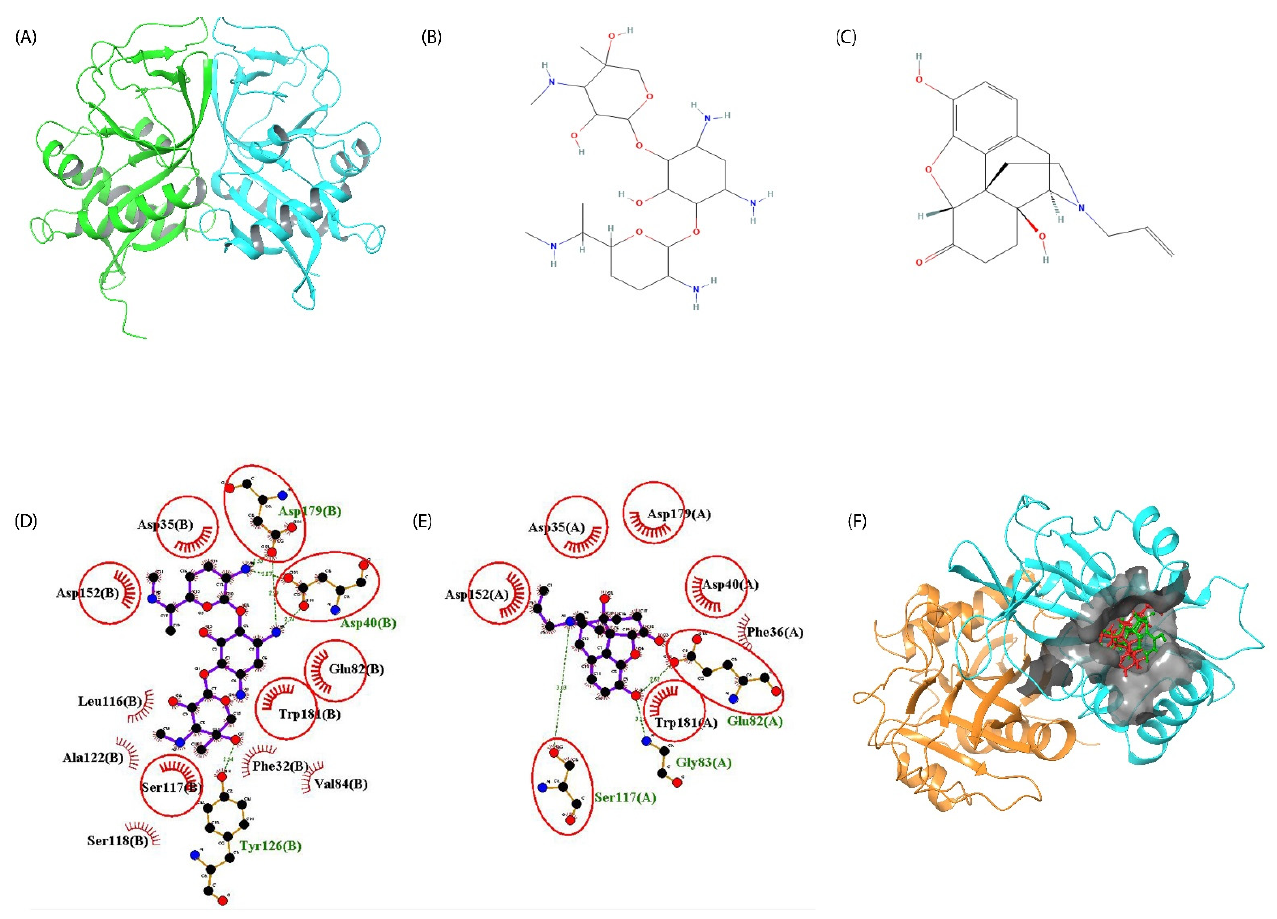
Figure 2. Comparison of 2D interaction profile. ( A ) The tertiary structure of AAC2 (cid:48) retrieved for protein data bank (PDB ID: 1M4I) with chain A colored in green and chain B colored in cyan. ( B ) Fischer projection of gentamicin. ( C ) Fischer projection of naloxone. ( D ) The surface visualization of the binding pocket in AAC2 (cid:48) is shown as a gray patch on which both gentamicin (red) and naloxone (green) compounds can be visualized, binding to the same region. The images were developed using Maestro v13.2 (Schrodinger 2022-2). ( E ) The 2D interaction profile of gentamicin with the interactive residues of AAC2 (cid:48) binding site. ( F ) The 2D interaction profile of naloxone with the interactive residues of AAC2 (cid:48) binding site. For C and D, the residues having hydrogen bonds are showcased in atomic representations with the bond length specified in angstrom. The hydrophobic interactions are shown in the residue name with a beaming red semicircle. The common residues in both interactions are encircled in red. The plot was developed using